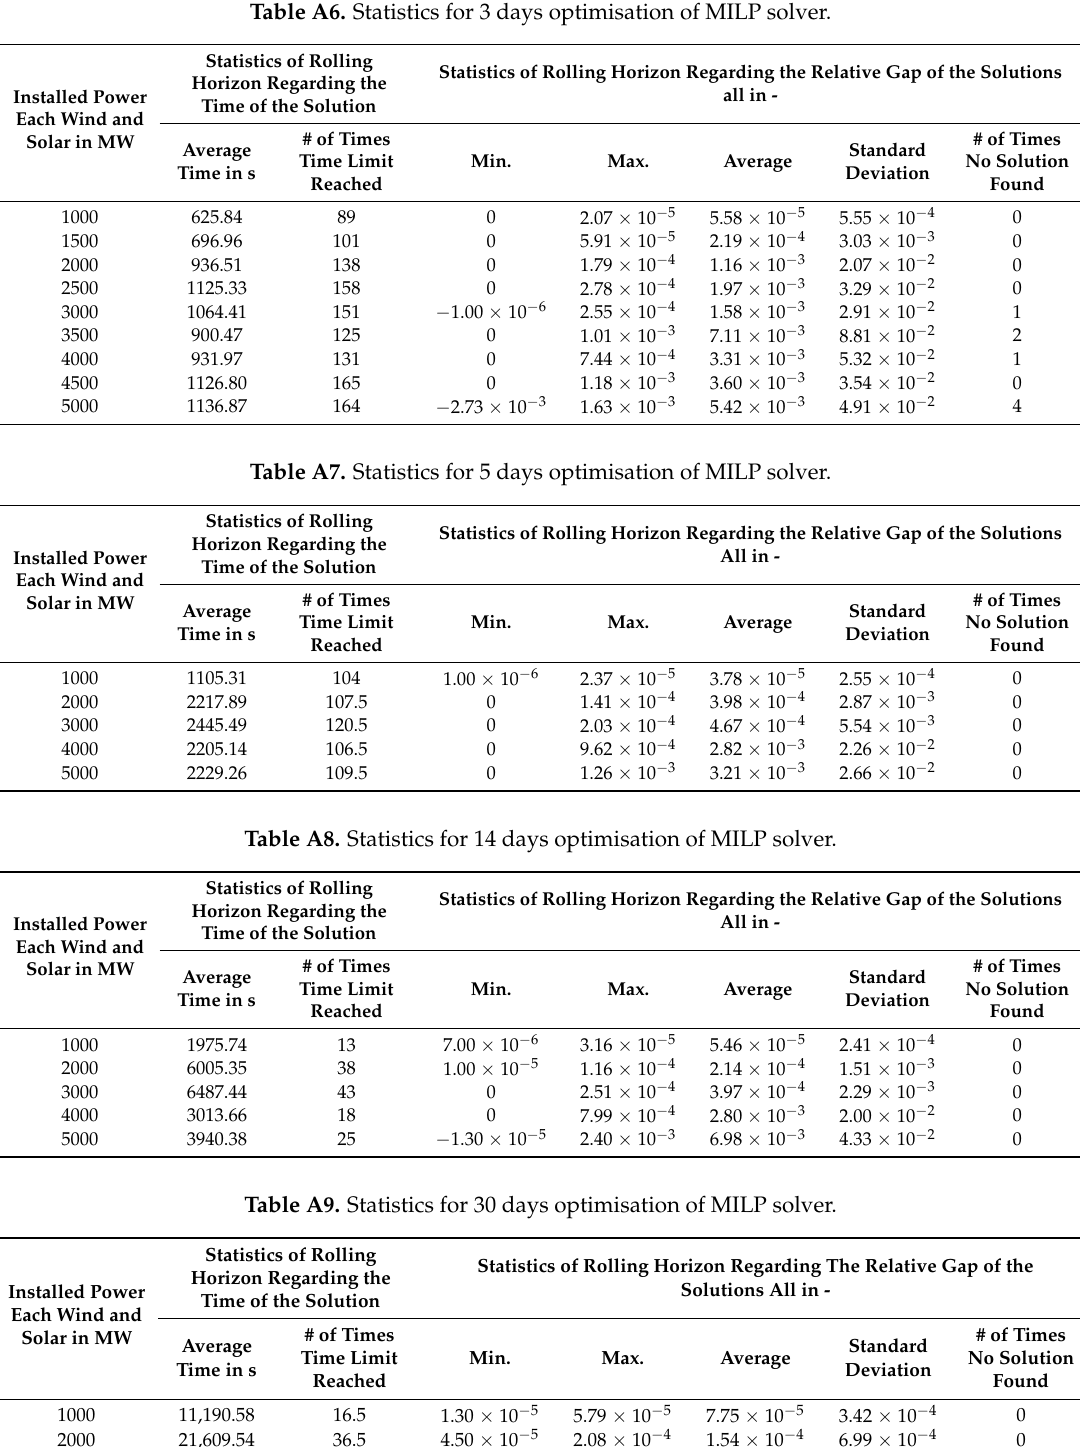
Table A6. Statistics for 3 days optimisation of MILP solver.